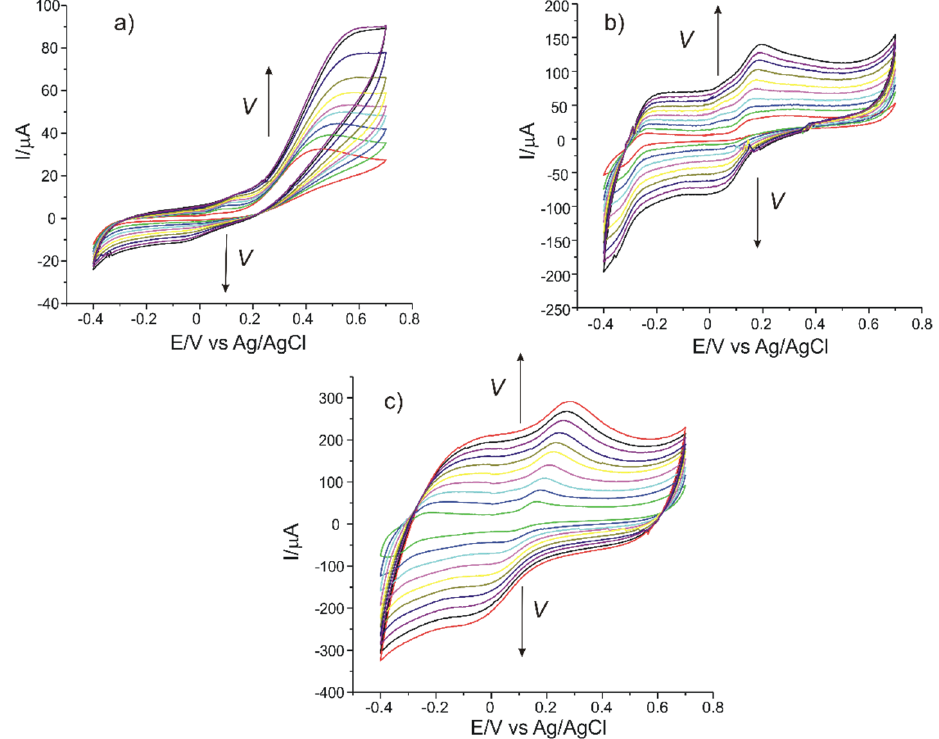
Figure 7. Cyclic voltammograms of ( a ) C-SPCE, ( b ) MC-SPCE and ( c ) OMC-SPCE immersed in 1 × 10 − 3 M L-DOPA solution recorded at various scan rates within the range 0.1–1.0 V·s − 1 .